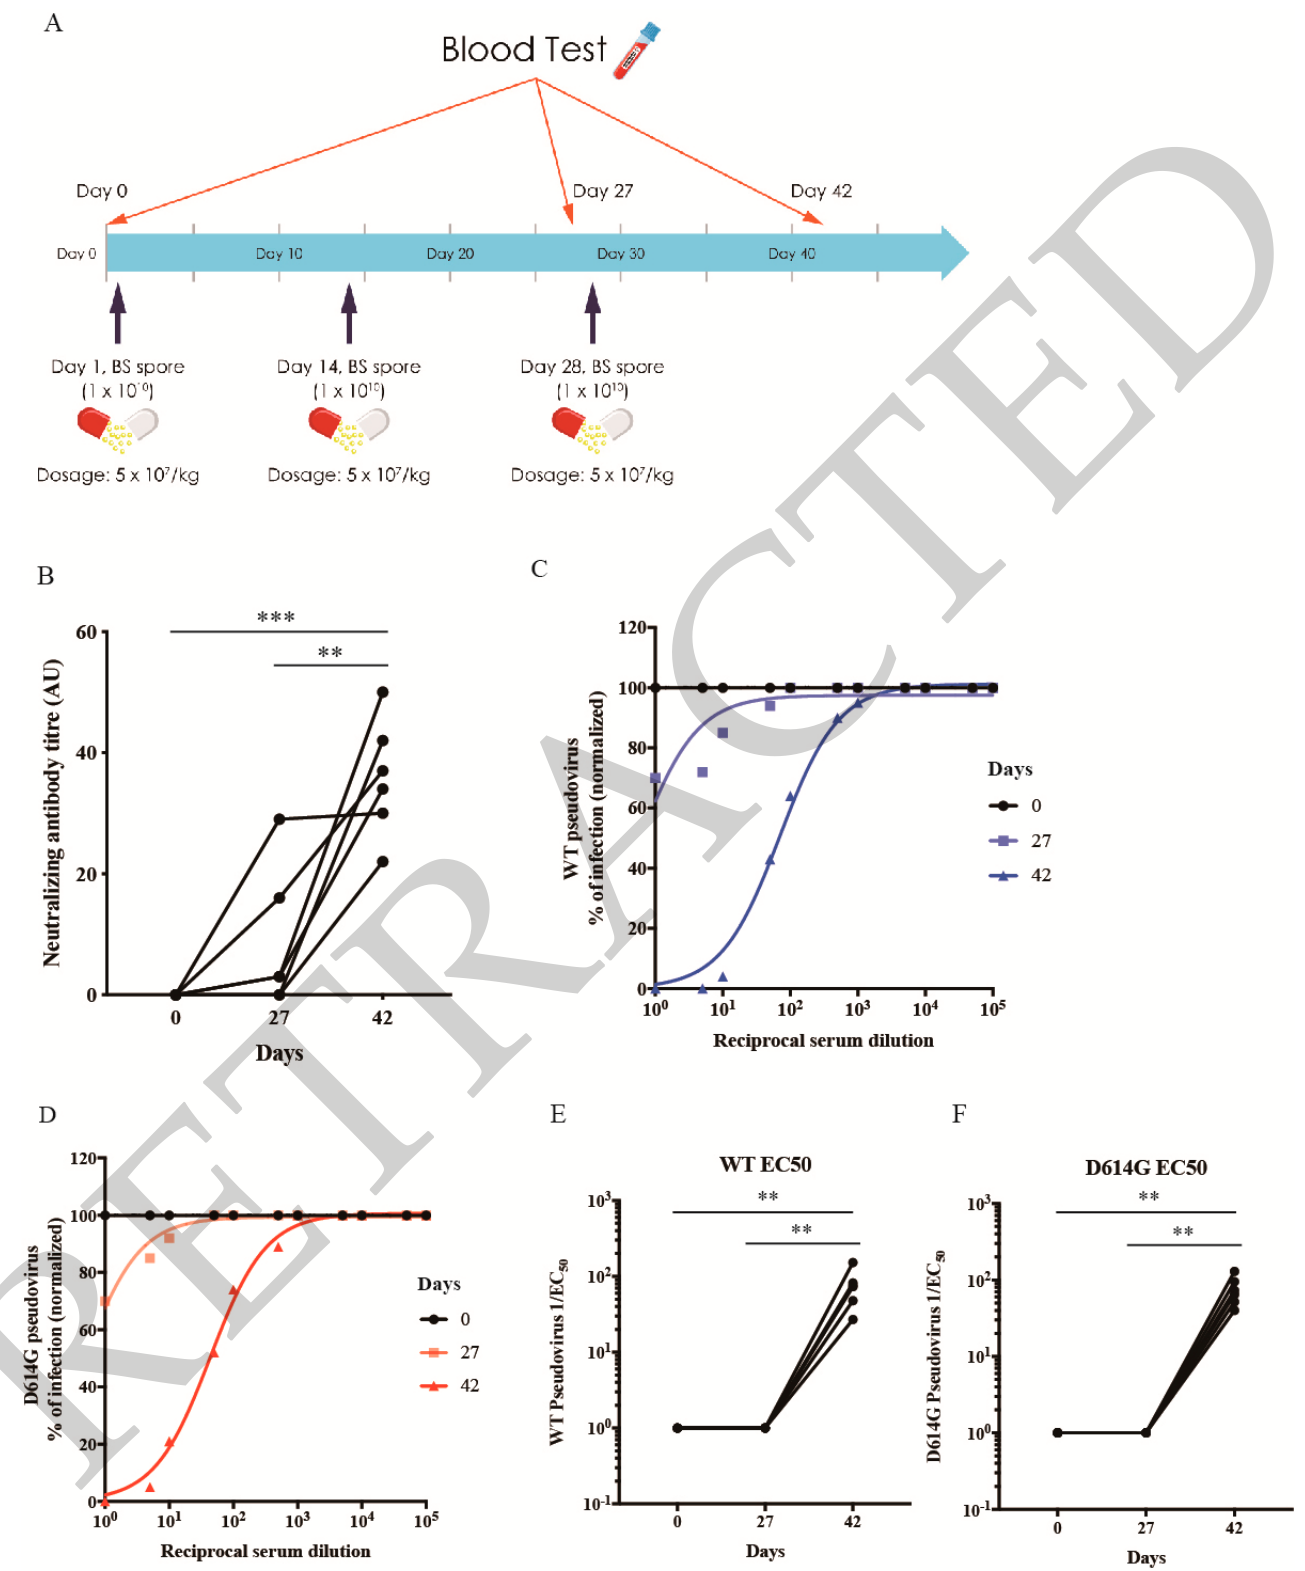
Figure 5. ( A ) Schematic presentation of the immunization schedule in humans. Healthy volunteers were orally administered with 5 × 10 7 spores/kg person of B. subtilis spores for three courses. ( B ) The antibody titers targeting the RBD of SARS-CoV-2 were measured with a CLIA-based assay.